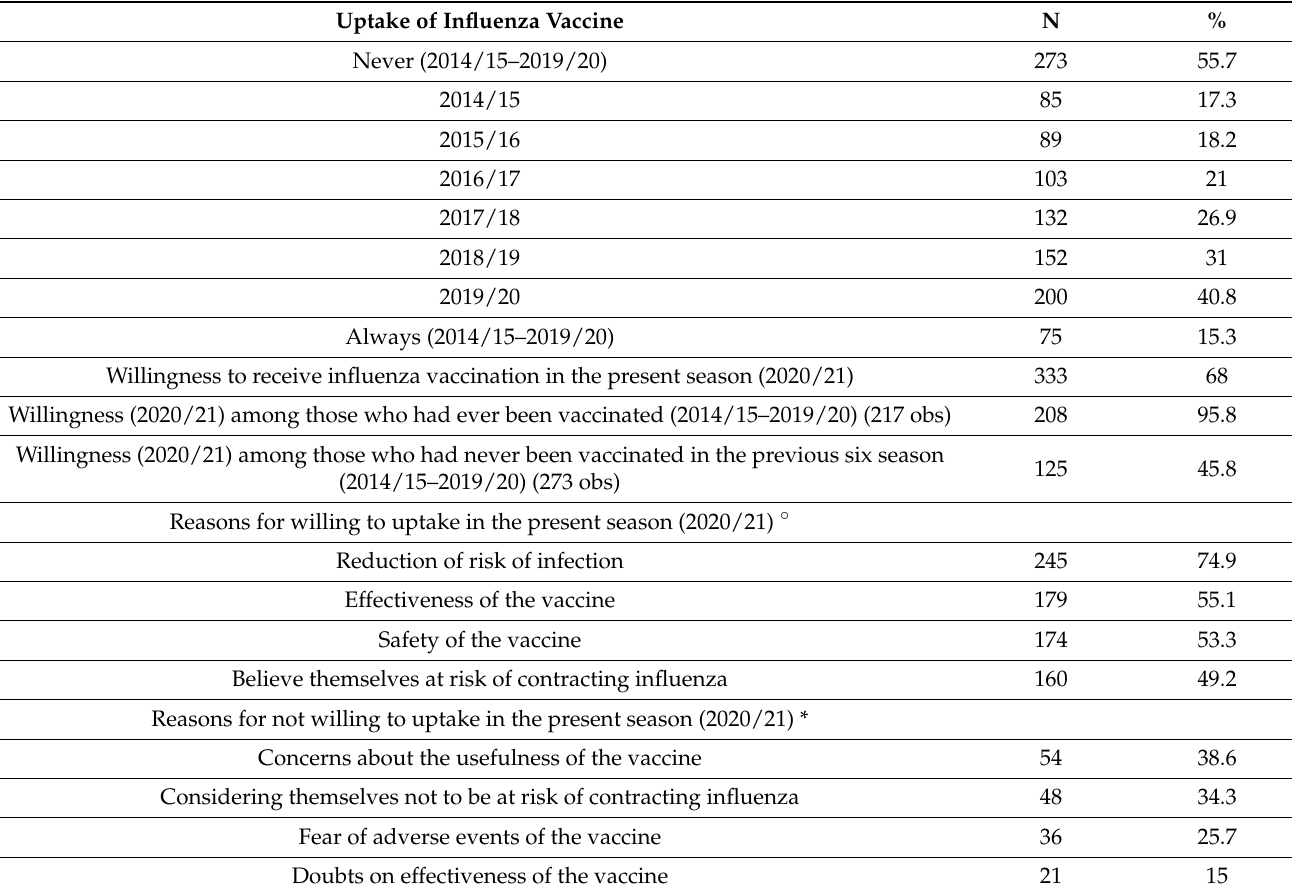
Table 2. Influenza vaccination uptake in previous seasons (2014/15–2019/20) and reasons for willingness to uptake in the 2020/21 season (490